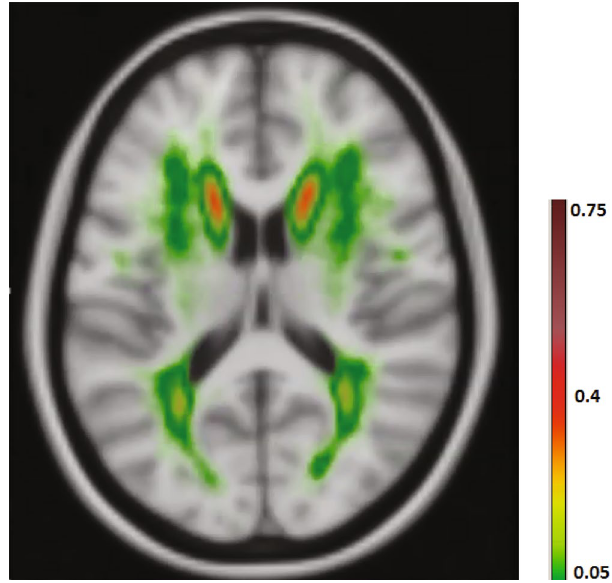
Figure 1. A pattern is observable in WMHs occurrence probability